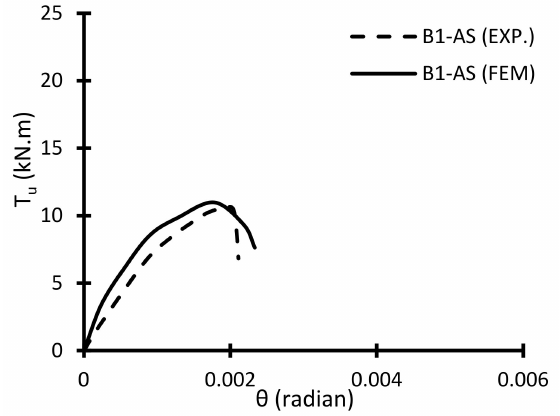
Figure 35. Torque–twist curves of the beam B0-Control (FE and EXP.).